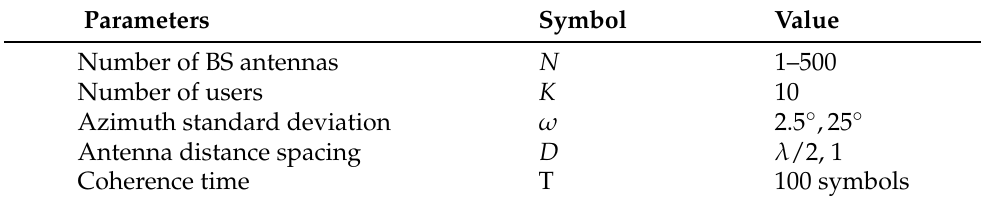
Table 2. Simulation